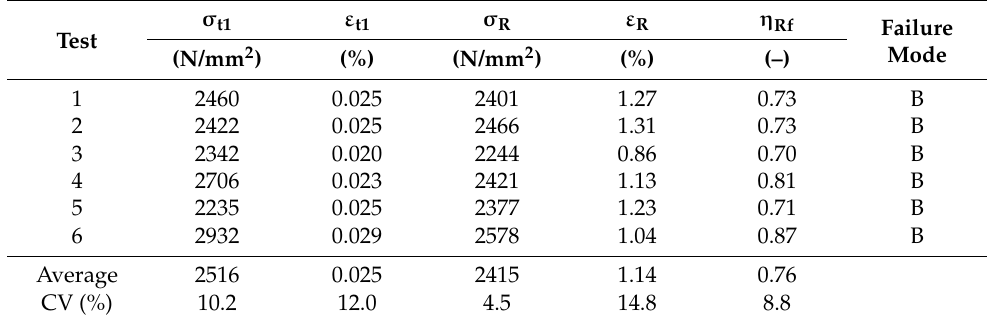
Table 10. P-MX test results.